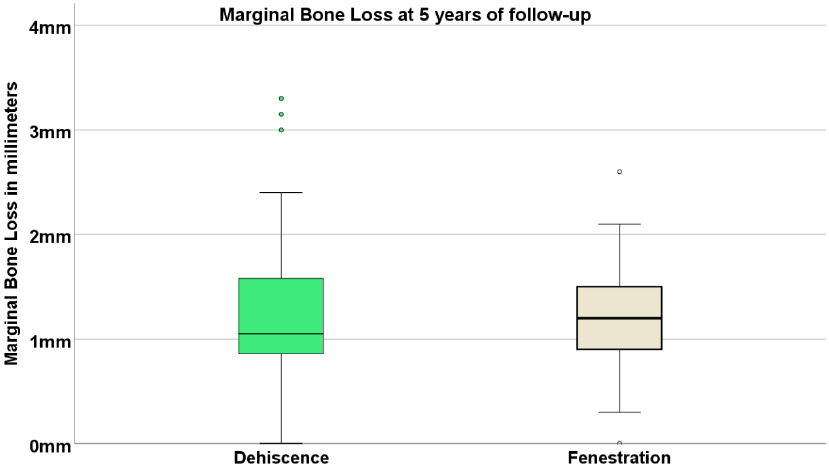
Figure 5. Boxplot illustrating marginal bone loss at 5 years in both groups. The lower box edge represents 25% of the sample; the upper box edge represents 75% of the sample; the horizontal black line represents the median; dots represent outlier values. Note that the median in both groups was localized below 1.25 mm at 5 years. The average (standard deviation) marginal bone loss at 10 years was 1.53 mm (0.75